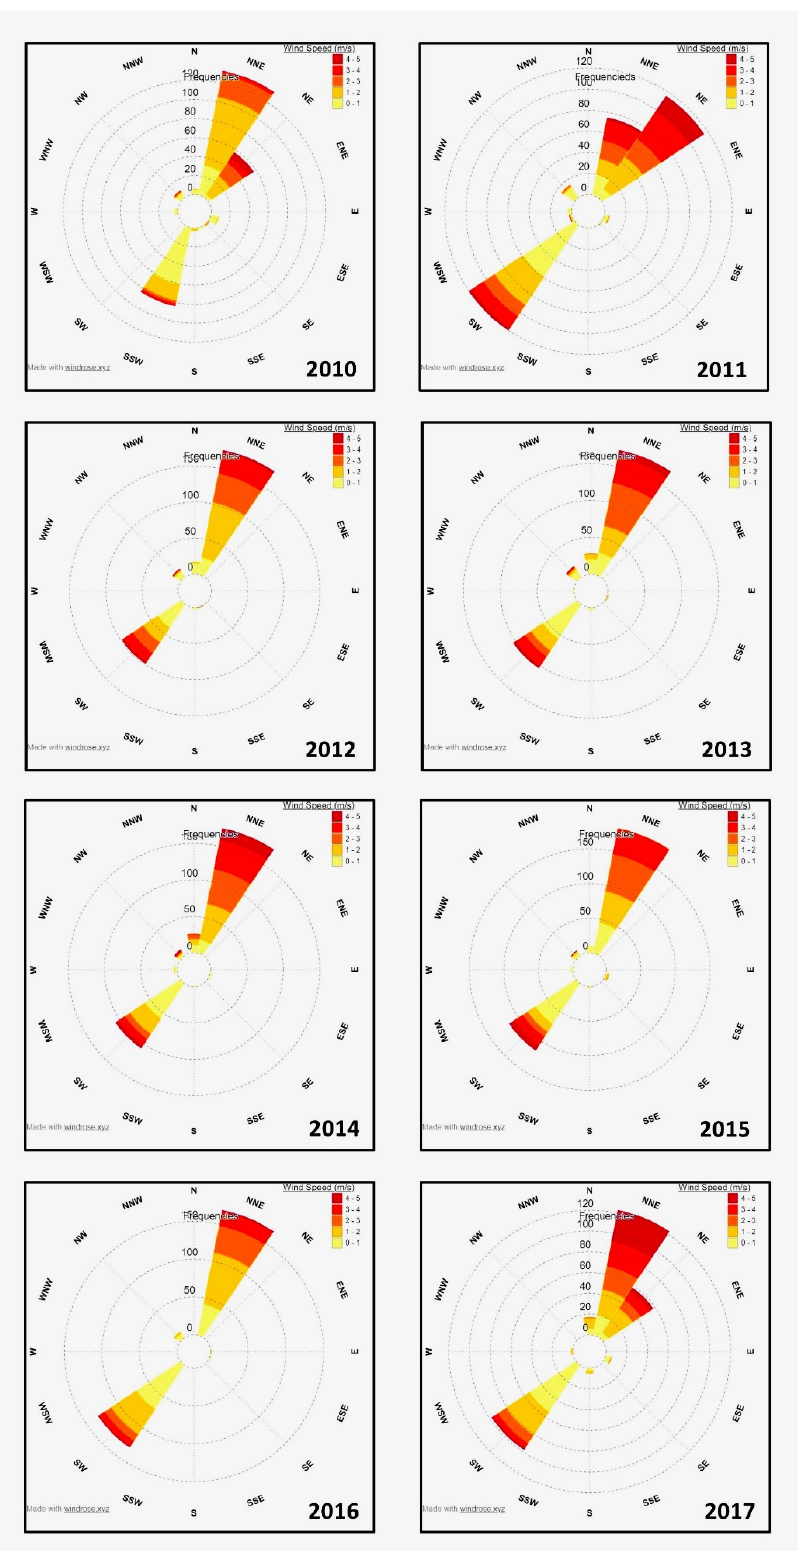
Figure 9. Wind Rose diagram of PAGASA–Cuyo Station (10.85° N Lat., 121.04° E Long.) from 2010–2017 (data source: PAGASA–Cuyo Station).